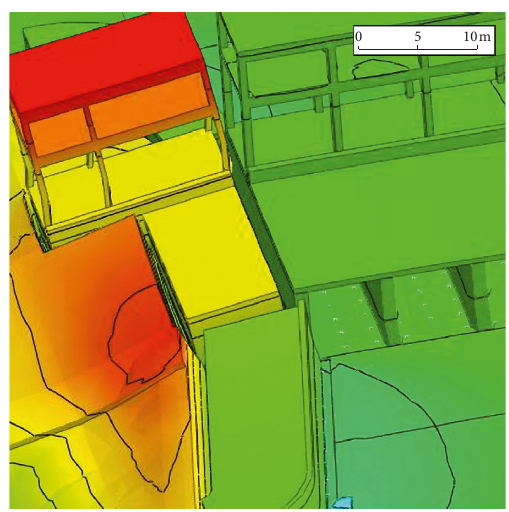
Figure 15: Gaps in a sluice engineering structure (shore side).